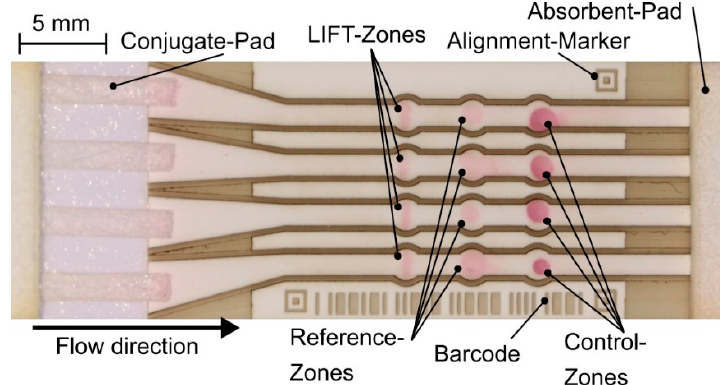
Figure 10. Prototype of fully laser fabricated multichannel lateral flow test. The laser structured nitrocellulose membrane consists of 4 parallel channels with 3 reaction zones each. For the proof of concept with CRP detection the first zone of each channel is functionalized with 120 nL of capture antibody solution (24,000 droplets with an individual volume of 5 pL) by BA-LIFT, while the other zones, which appear far less precisely defined, are manually spotted.